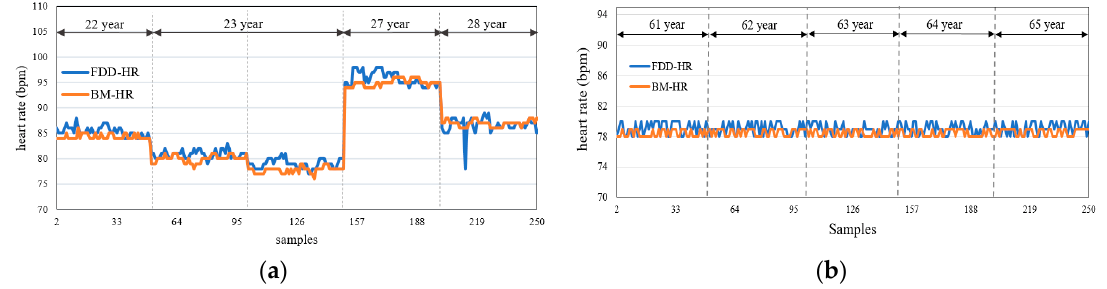
Figure 10. HR measurements for ( a ) five adult volunteers (ages 22 to 28), and ( b ) five elderly volunteers (ages 61 to 65).